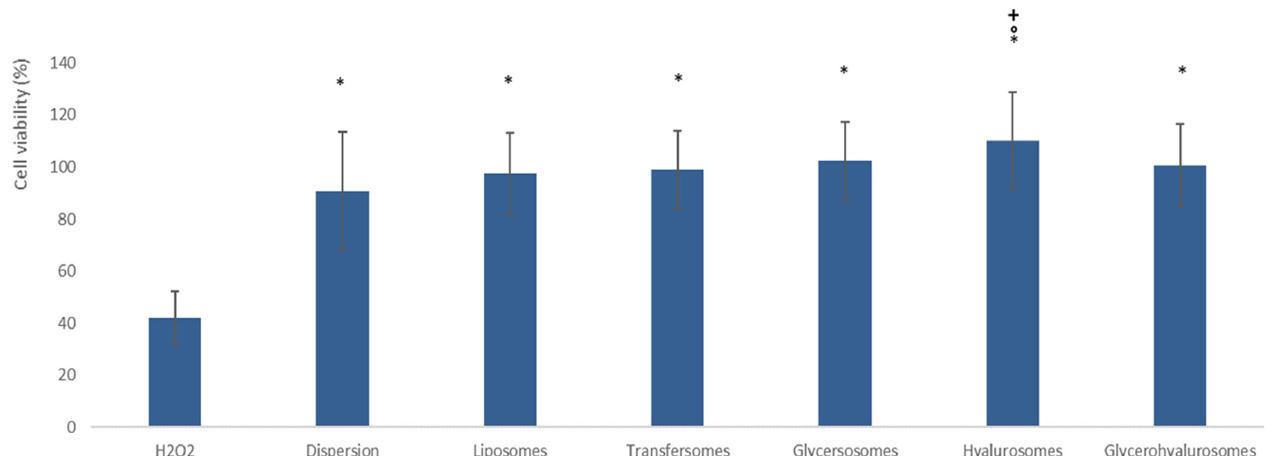
Figure 5. Viability of fibroblasts stressed with hydrogen peroxide and treated with T. marum extract in dispersion or loaded in vesicles. Mean values ± standard deviations are reported. The symbol * indicates values that were statistically different from hydrogen peroxide ( p < 0.01); the symbol ◦ indicates values that were statistically different from the dispersion of the extract ( p < 0.05); and the symbol + indicates values that were statistically different from liposomes ( p < 0.05).